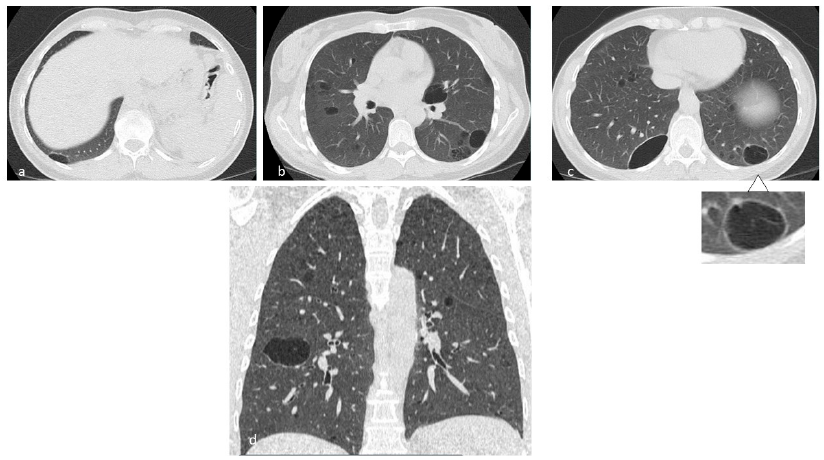
Figure 9. LIP cysts, mostly distributed in peribroncovascular regions ( a – d ). Multiplanar reconstructions (MPR) in the coronal plane ( d ).